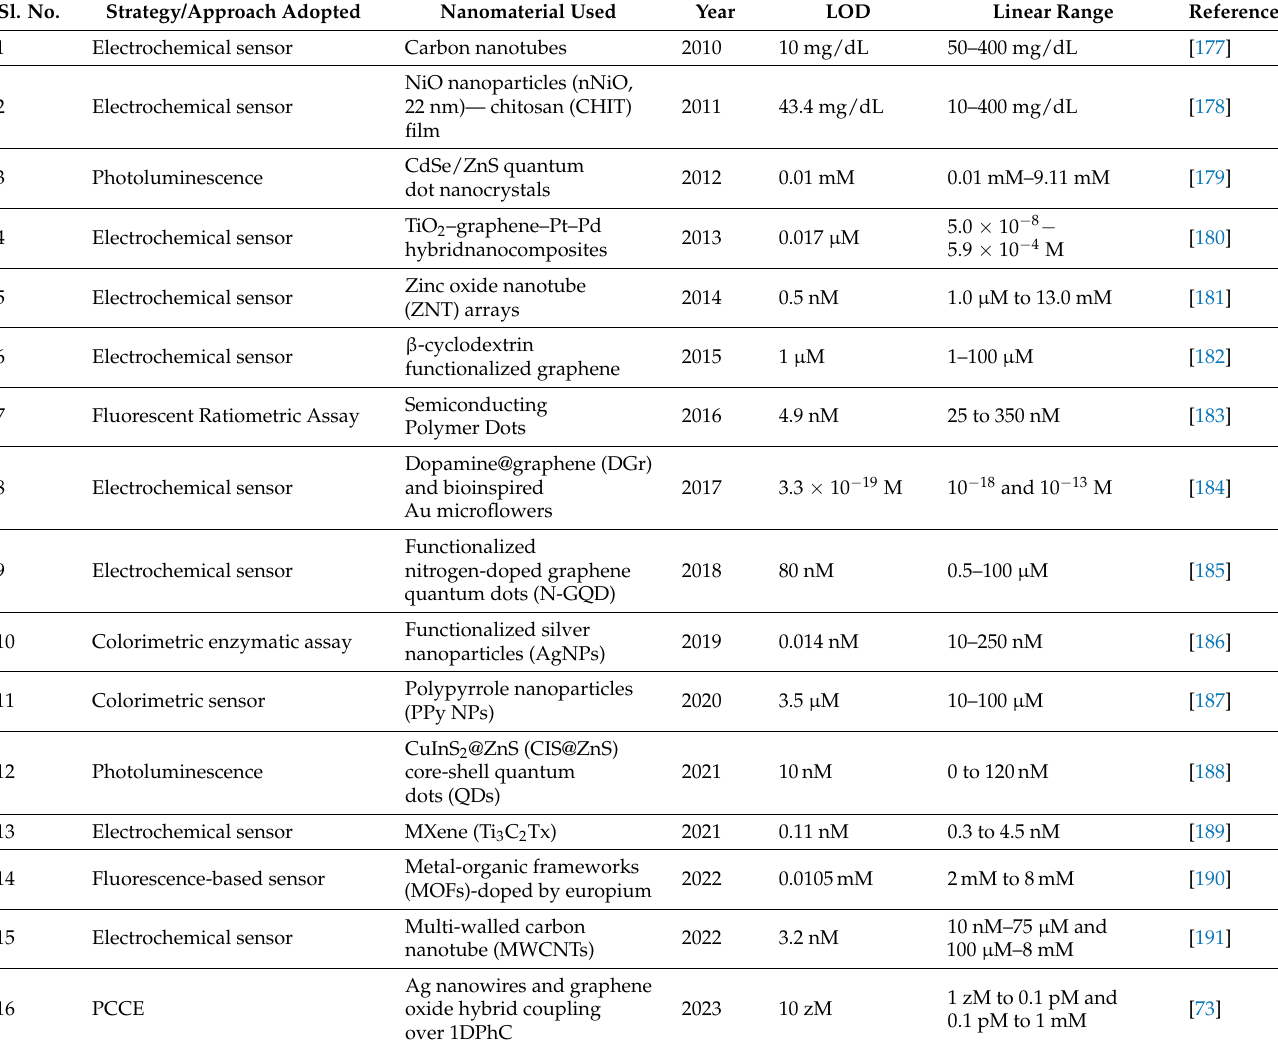
Table 3. Comparison of the performance of the techniques/strategies developed to detect choles- terol with the PCCE platform, presented along with the limit of detection (LOD) and the linear sensing